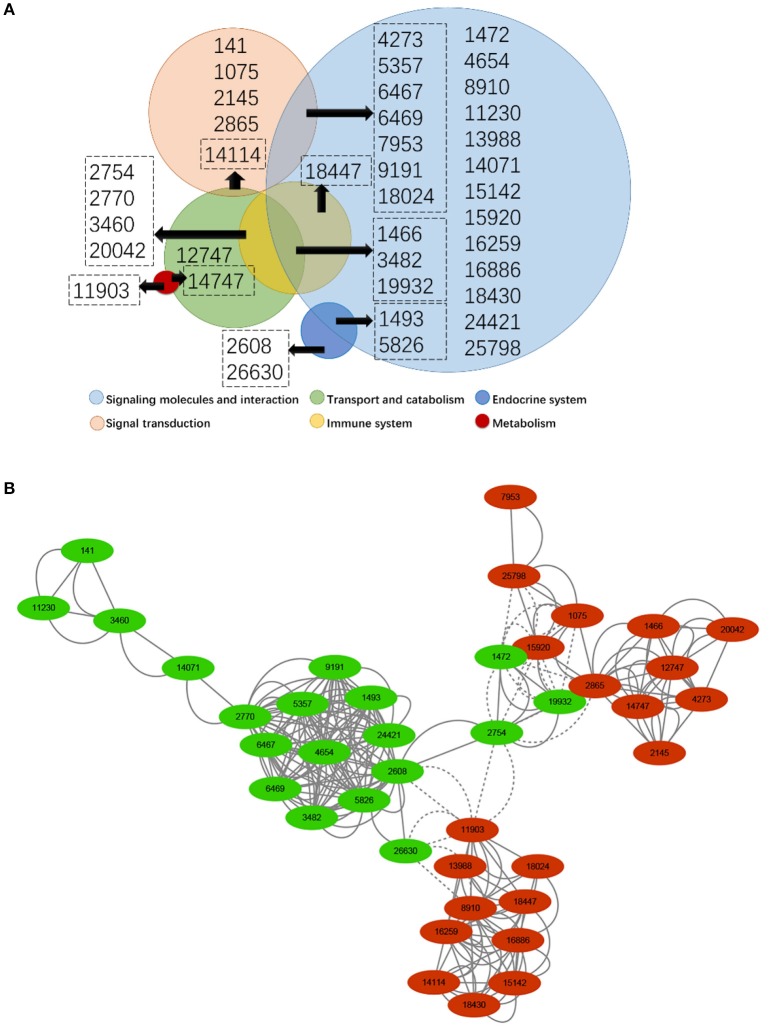
Analysis of genes involved in different pathways under various categories (A) and co-expression network of significantly changed genes (B). In (A), the circles with different colors show the pathways in different categories, and the circle size is positively correlated with the number of genes in each corresponding category. In (B), green indicates down-regulated genes, while red indicates up-regulated genes. The dot size is positively correlated with the fold change of genes. Values inside all circles and dots are the number of genes shown in Table 3.